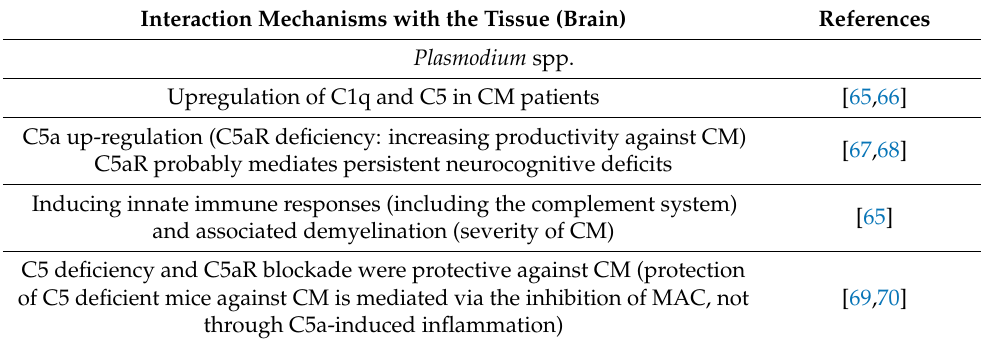
Table 1. Interactions between Toxoplasma / Plasmodium parasites and complement system in infected brain